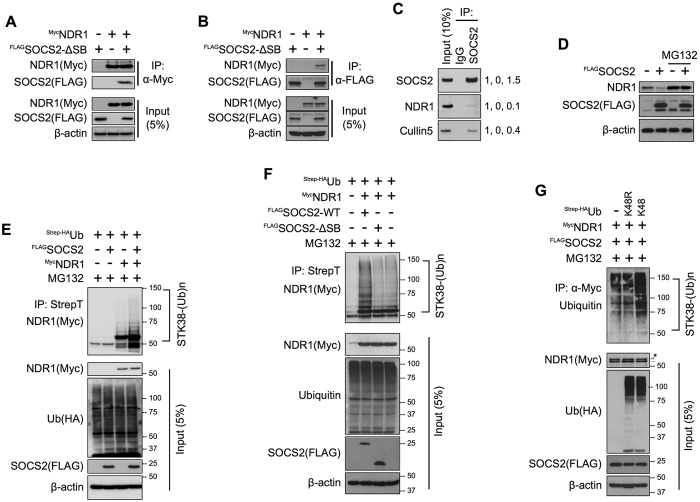
SOCS2 interacts with NDR1 and promotes its ubiquitin-mediated degradation.(A,B) FLAG-SOCS2-ΔSB and Myc-NDR1 were expressed in MEFs either alone or together. Lysates were immunoprecipitated with anti-Myc (9E10) antibody (A) or anti-FLAG M2 antibody (B) and subjected to SDS–PAGE followed by IB. (C) HEK293T cells grown to ~80% confluency were harvested. Lysates (2 mg) were subjected to IP with anti-IgG or anti-SOCS2 antibody followed by IB with the indicated antibodies. Values on the right are densitometric quantifications with the corresponding “Input” band taken as 1. (D) MEFs were transfected with FLAG-SOCS2 plasmid as shown. Cells were treated with 10 μM MG132 or an equal volume of DMSO for 16 hrs before harvesting. Lysates were prepared and IB was done as previously. (E,F) Plasmids for HA-Strep-Ubiquitin and Myc-NDR1 were co-expressed in MEF cells with FLAG-SOCS2 (E) or FLAG-SOCS2 and FLAG-SOCS2-ΔSB (F) as shown. Cells were treated with 10 μM MG132 or an equal volume of DMSO for 16 hrs before harvesting. Lysates were prepared from 36 hrs post-transfected cells and subjected to pull-down using StrepTactin resin followed by IB. (G) Plasmids for HA-Strep-Ubiquitin-K48 or K48R and Myc-NDR1 were co-expressed in HEK293T cells with FLAG-SOCS2 as shown. Cells were treated with 10 μM MG132 or an equal volume of DMSO for 16 hrs before harvesting. Lysates were prepared from 36 hrs post-transfected cells and subjected to pull-down using anti-Myc (9E10) antibody followed by IB. Lysates were probed by IB. Full-length blot of 3D (NDR1) are presented in Supplementary Figure S4.